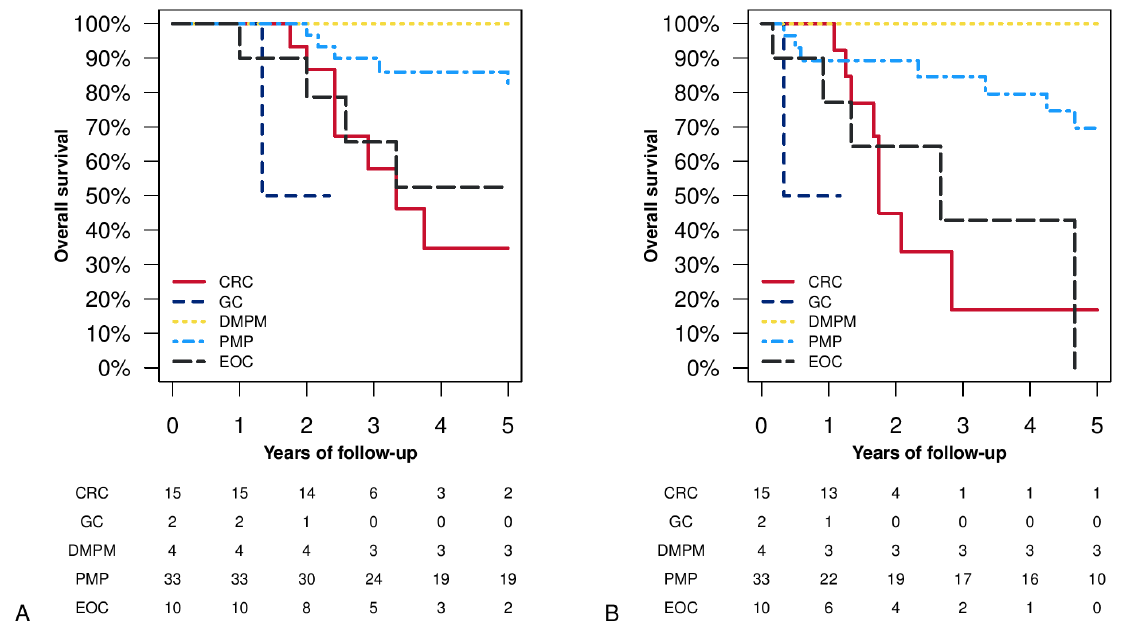
Figure 1. Overall survival (Kaplan–Meier analysis) stratified by histology: panel ( A ) survival from the first CRS and HIPEC procedure; panel ( B ) survival from the second CRS and HIPEC procedure. Acronyms: CRC = colorectal cancer; GC = gastric cancer; DMPM = diffuse malignant-peritoneal- mesothelioma; PMP = pseudomyxoma peritonei; EOC = epithelial ovarian cancer.